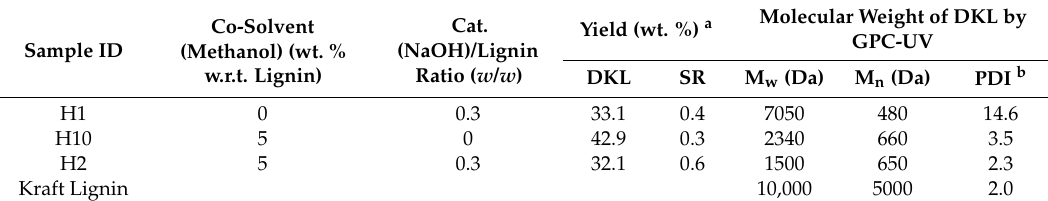
Table 5. Effects of methanol addition to black liquor on M w , polydispersity, and product yields at 250 ◦ C for 2 h.